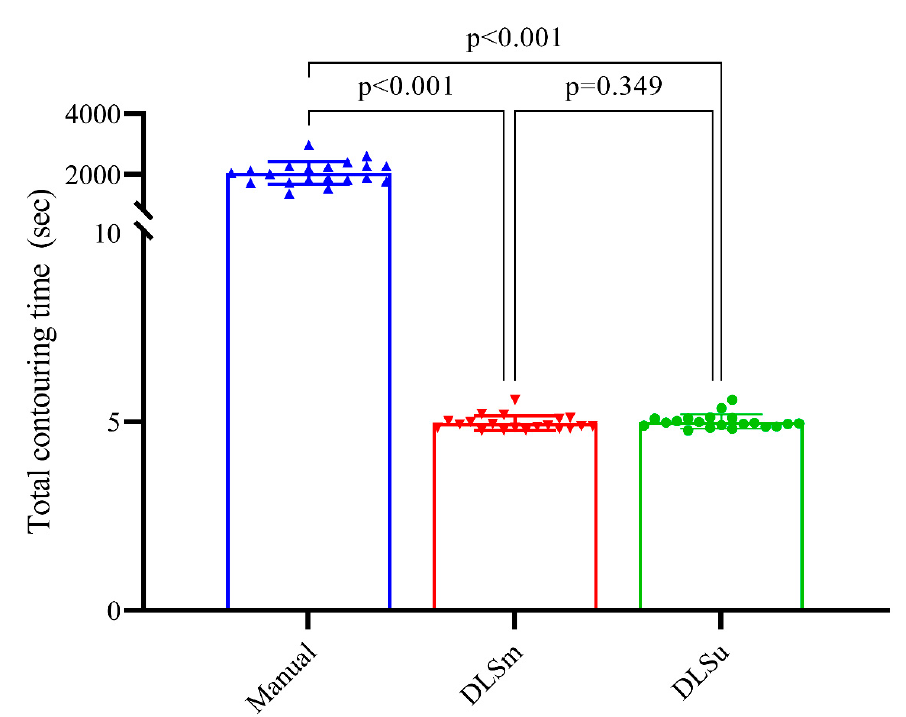
Figure 4. Mean and standard deviation of contouring time for 23 structures. Abbreviations: DLSu, deep learning-based segmentation using the unmatched training set; DLSm, deep learning-based segmentation using the matched training set.